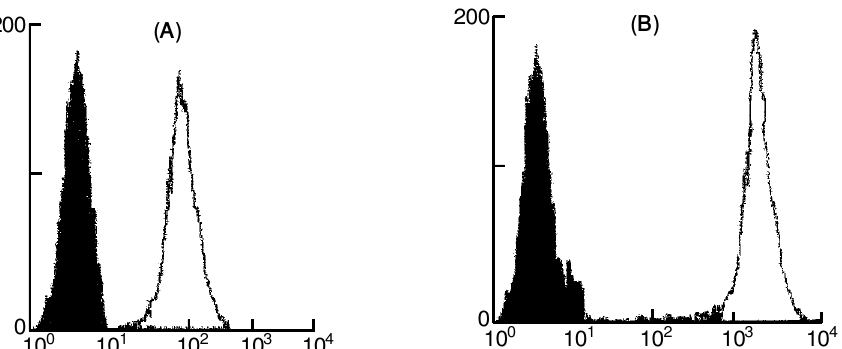
FIG. 1. Immunofluorescence histogram showing Bcl-2 expression lymphocytes of bronchoalveolar lavage from controls (A), and patients with active Behçet’s disease (BD) with pulmonary manifestations (B). The black histograms indicate fluorescence intensity of control antibodies. Data are representative of 10 normal controls and eight active BD. Bcl-2 was expressed in CD3+ BAL-T lymphocytes at a higher intensity.